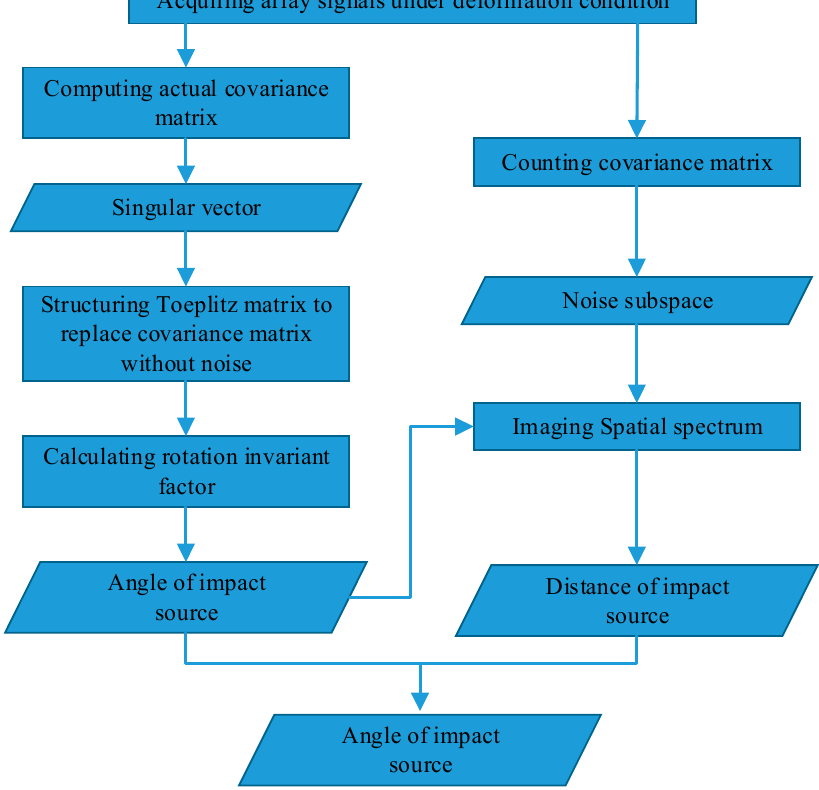
Figure 6. Block diagram of present TAM-MUSIC approach.